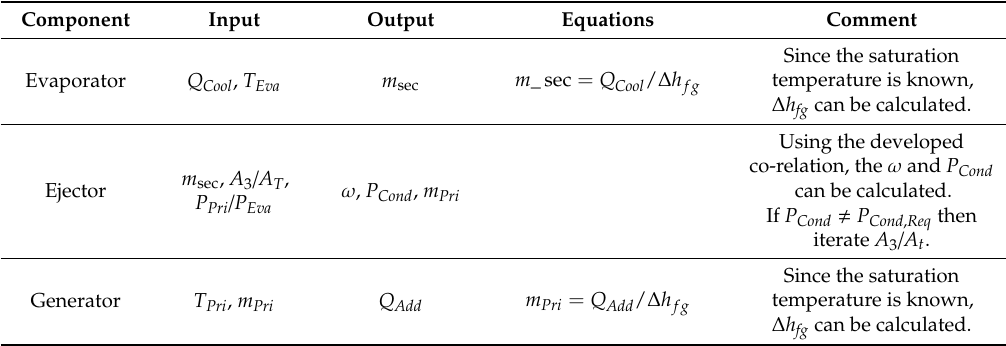
Table 5. Summary of calculation